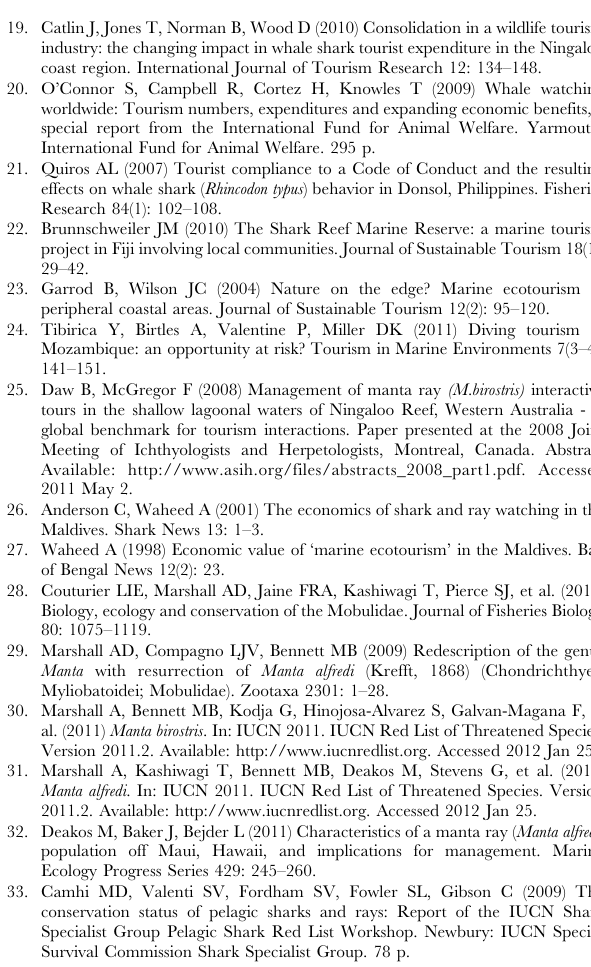
Table S2 Direct Economic Impact of Manta